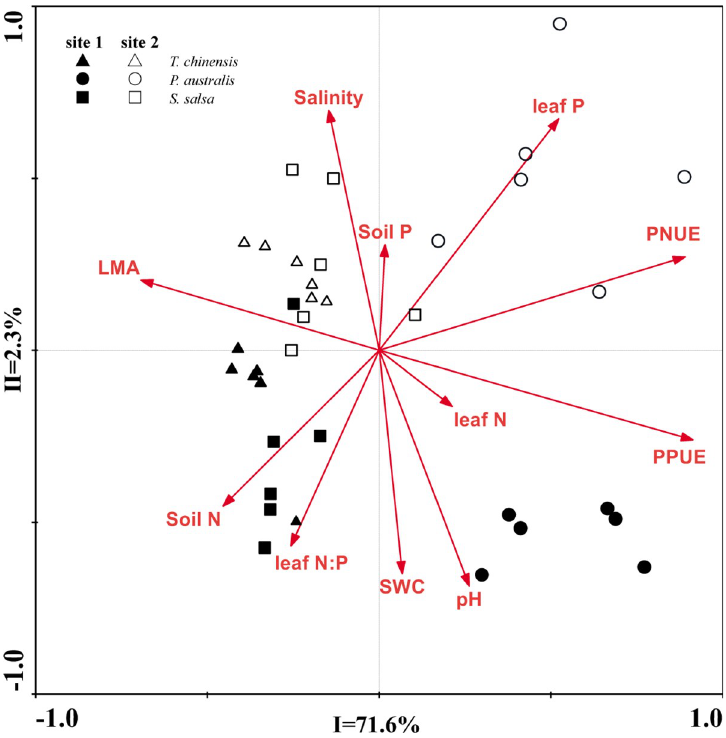
Fig 8. Redundancy analysis (RDA) of relationships between gas exchange characteristics and the influencing factors of halophytic plant communities.